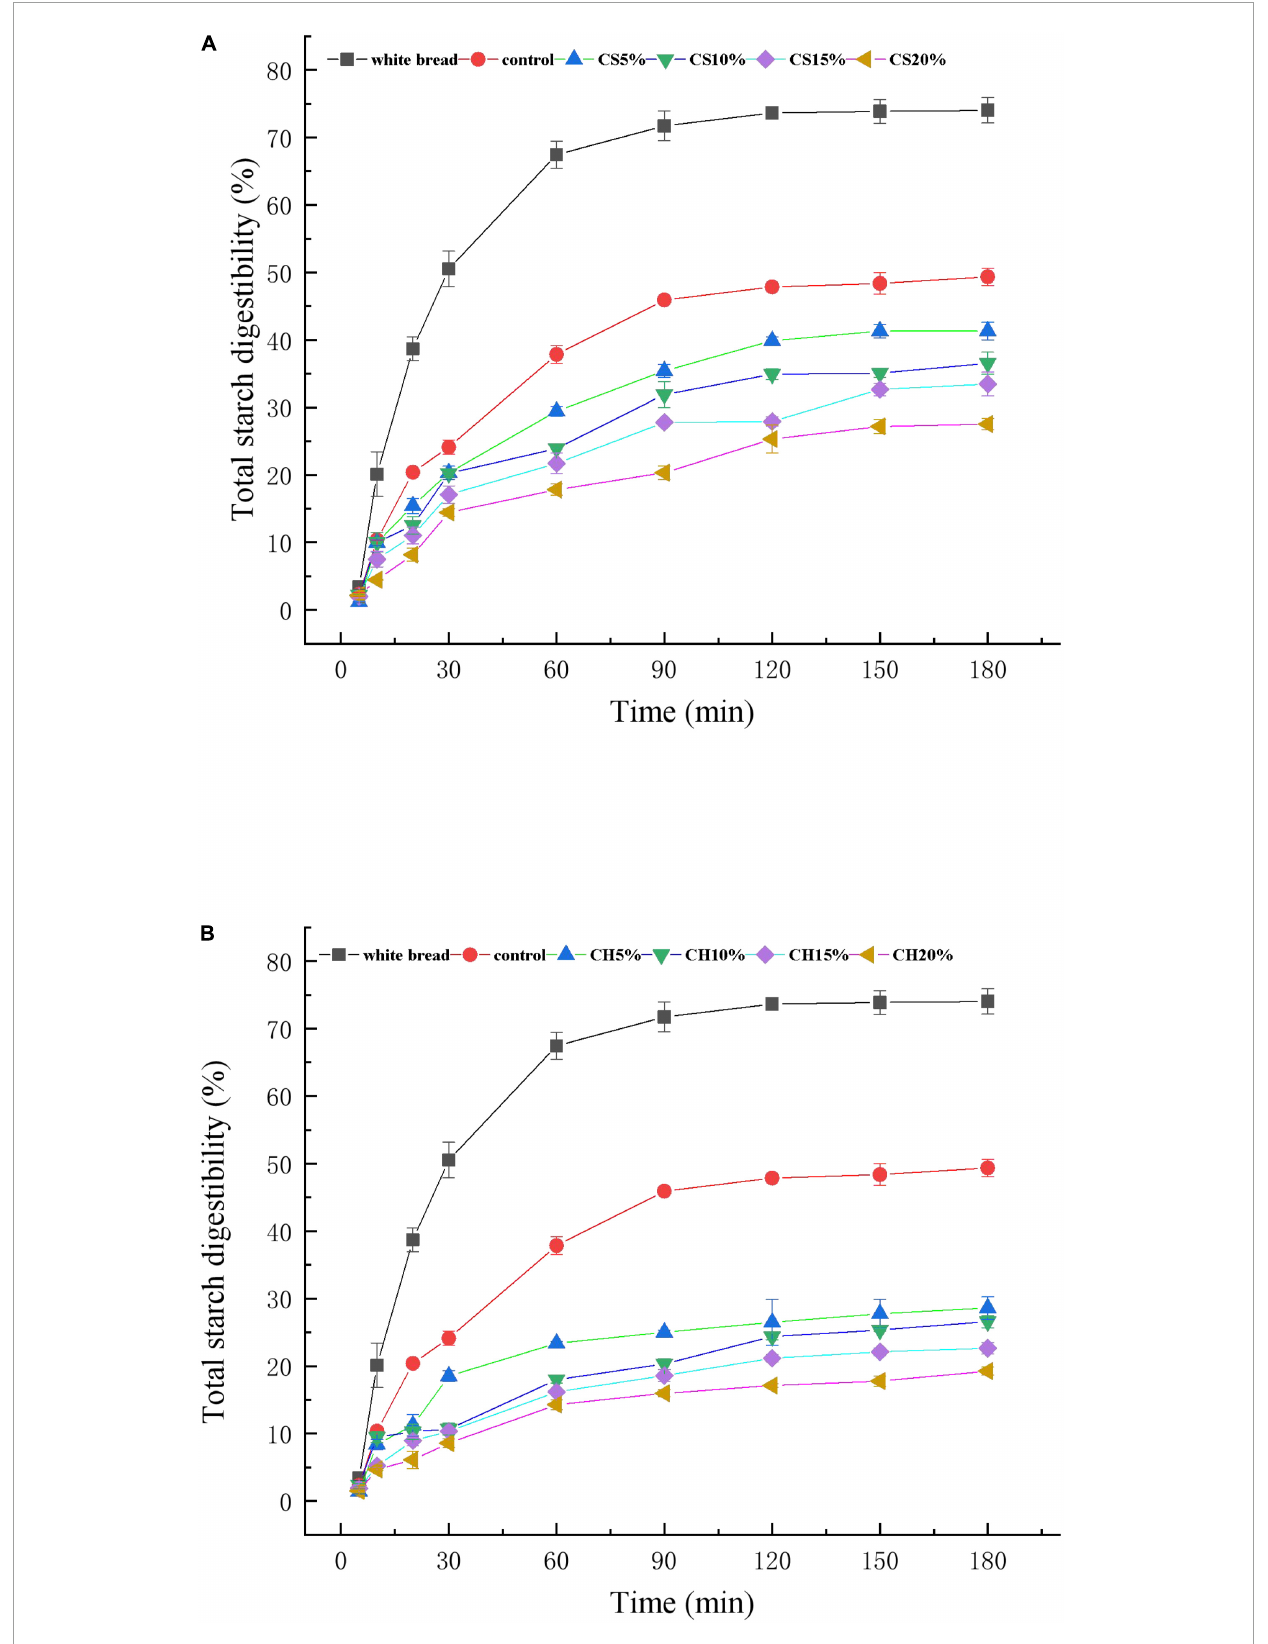
FIGURE5 Impact of CS (A) or CH (B) on the in vitro hydrolysis profiles of starch in CH-biscuits and CS-biscuits at different additions (CS or CH/flour = 5, 10, 15, and 20%); White bread as a reference; Error bars represent standard deviation from the mean of triplicate measurements.